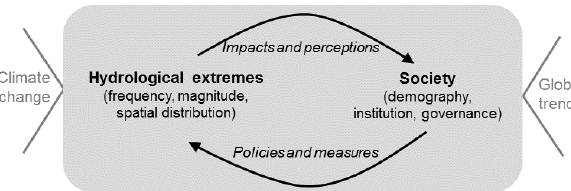
Figure 3. Hydrological extremes in the Anthropocene. Internal feedbacks within the human–water system (grey area, focus of this paper) at the local scale, and external drivers of change that operate at larger/global scale such as climate change and socio-economic